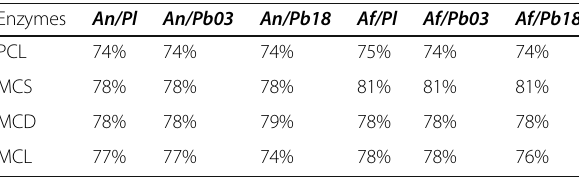
Table 1 Identity of Paracoccidioides spp. MCC enzymes when compared with functionally characterized enzymes